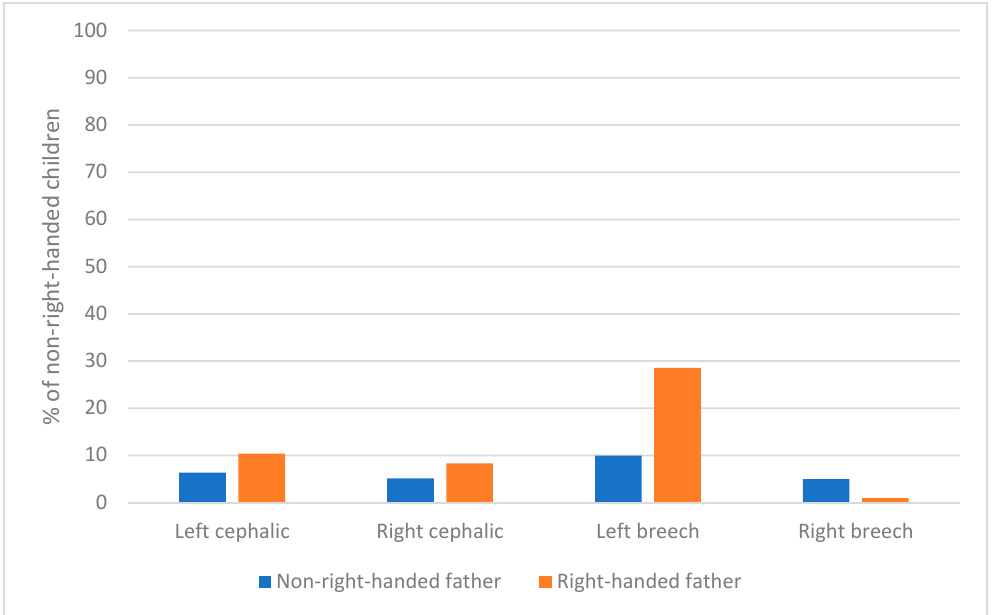
Figure 8. Distribution of the 12% left-handed children at 5 as a function of fathers’ handedness and presentation and side of presentation ( n = 96).